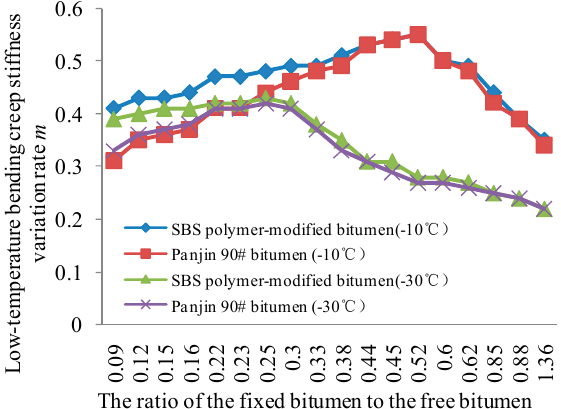
Figure 7. Influence of the fixed bitumen-free bitumen ratio on the low-temperature bending creep stiffness variation rate m.